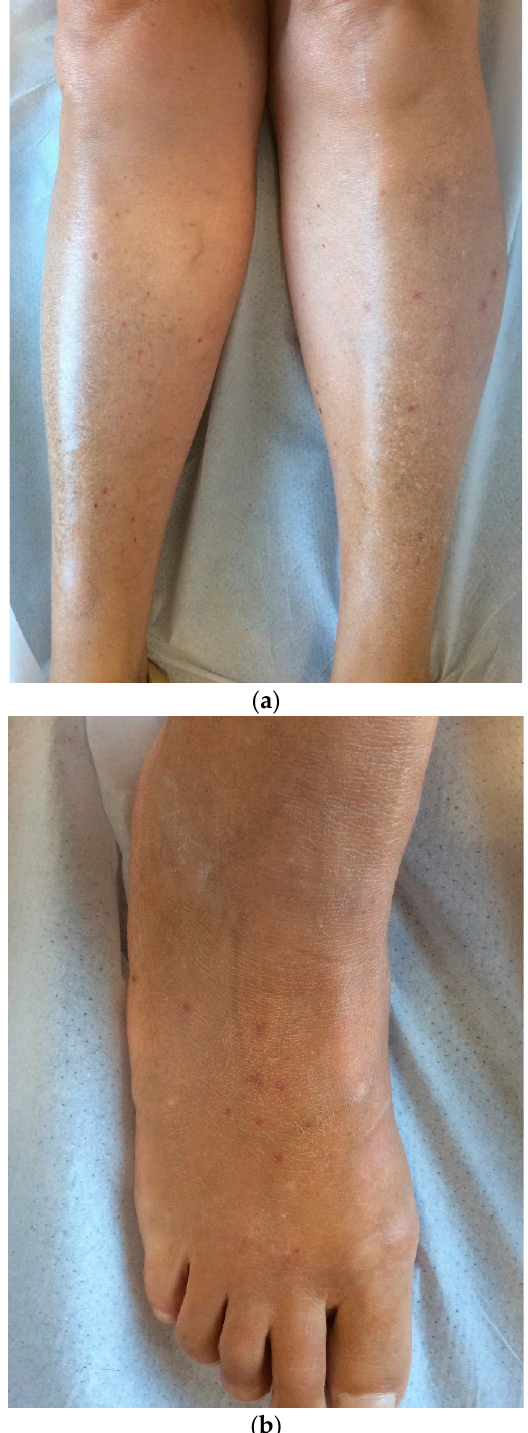
Figure 5. Scattered purpura on lower limbs ( a ) and feet ( b ) of a female patient who tested positive for COVID ‐ 19 on antibody testing without additional significant clinical